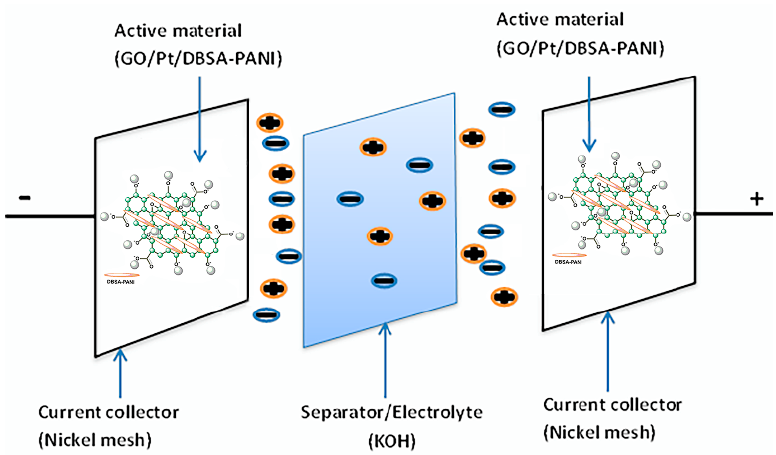
Figure 2. Schematic illustration of the GO/Pt/DBSA–PANI-based supercapacitor cell.